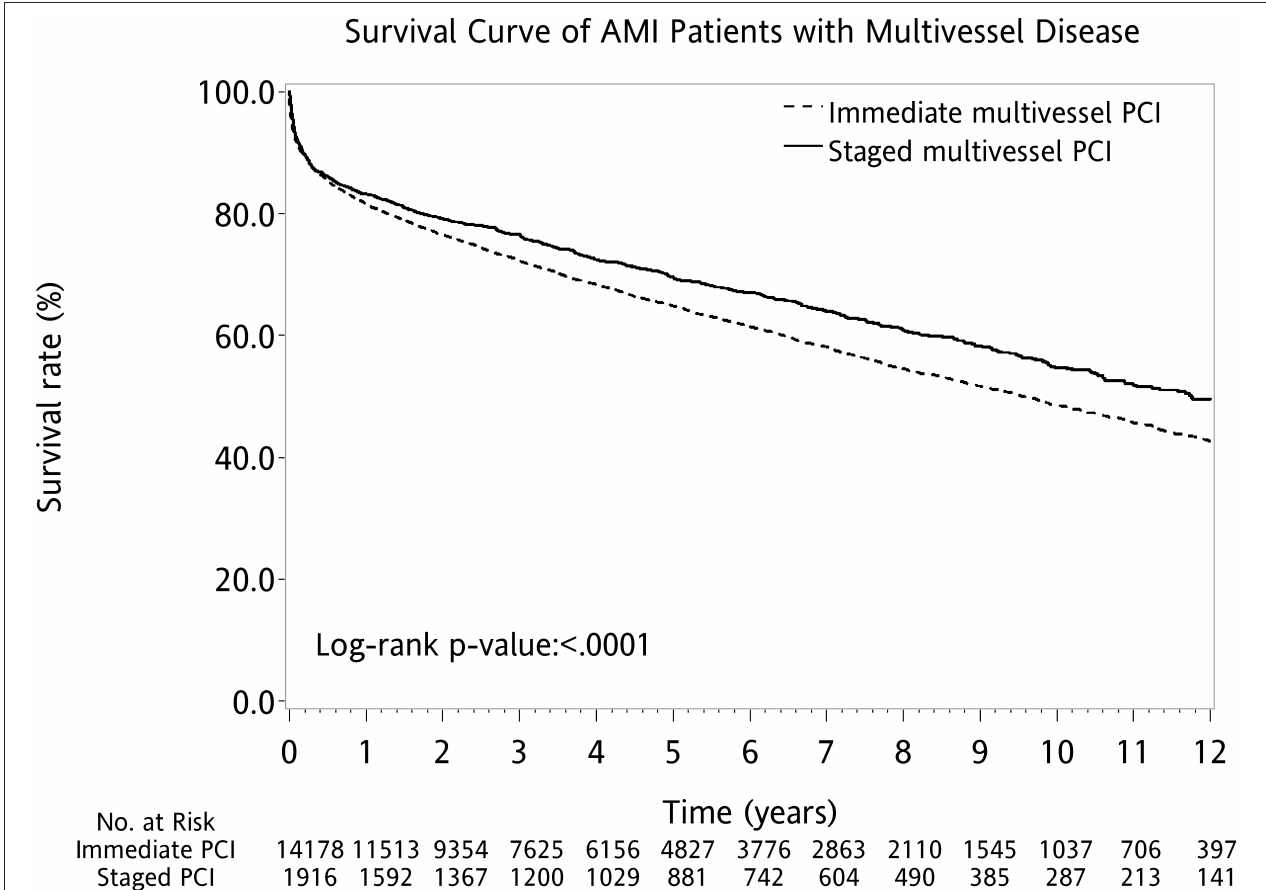
FIGURE 3 | Kaplan–Meier survival curves for survival after first AMI with multivessel disease. AMI, acute myocardial infarction; PCI, percutaneous coronary